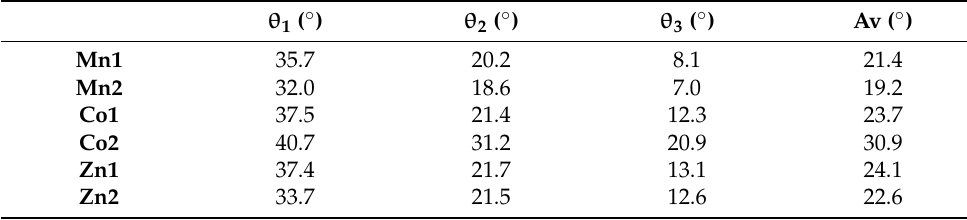
The [Co1H L ] + complex occurs as the ∆ ( δ , δ , δ , δ ) and Λ ( λ , λ , λ , λ ) enantiomeric pair with